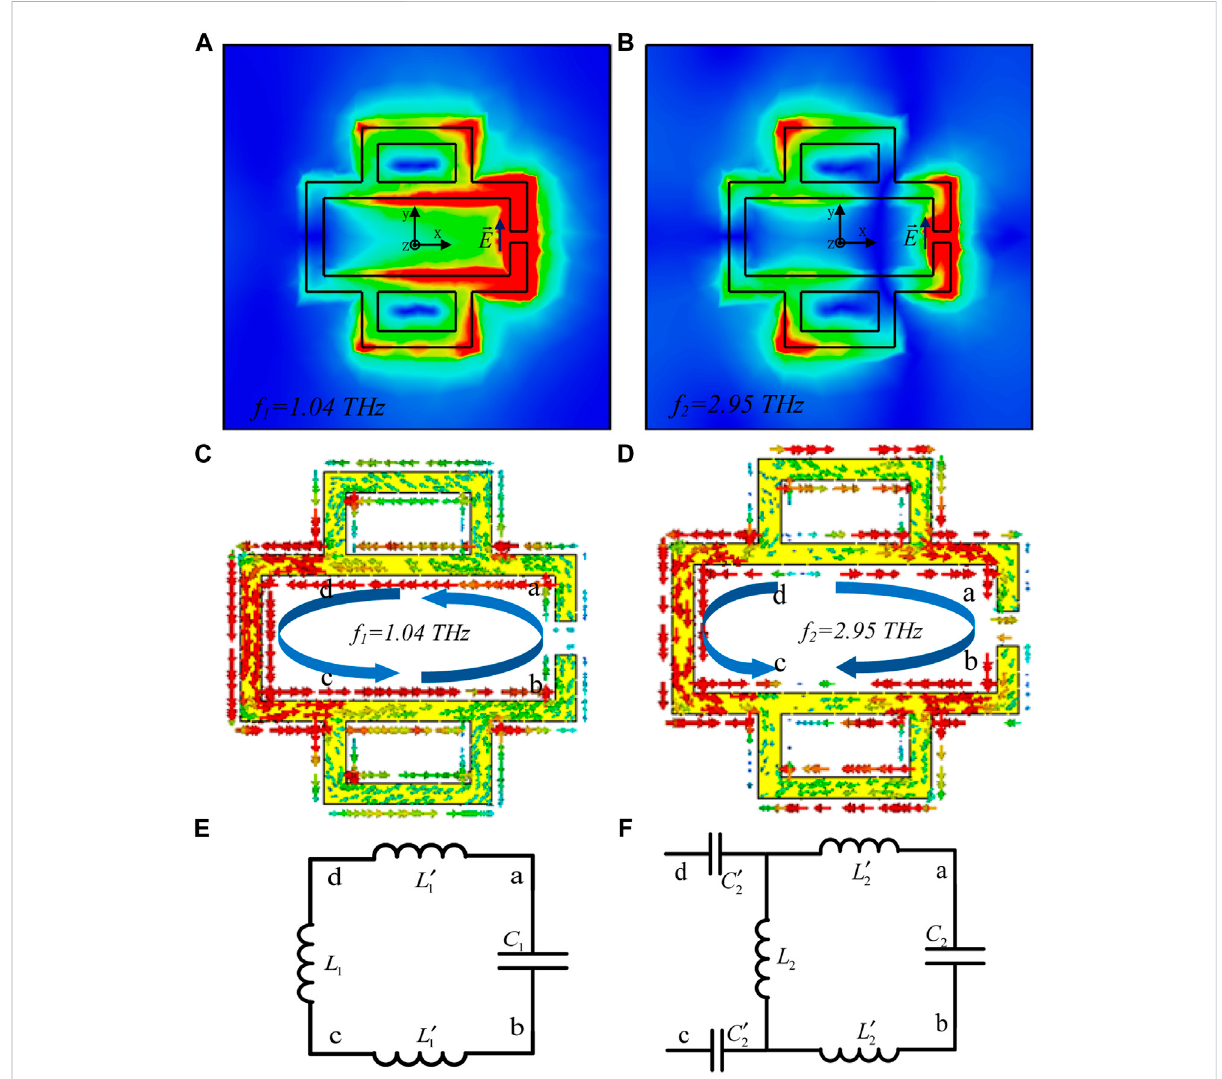
FIGURE 2 E- fi eld distributions ofthedesignedCRSRR at (A) f 1 =1.04 THz, (B) f 2 = 2.95 THz;Surfacecurrentdistributions ofthedesigned CRSRR at (C) f 1 = 1.04 THz and (D) f 2 = 2.95 THz; Equivalent circuit models at (E) f 1 = 1.04 THz and (F) f 2 = 2.95